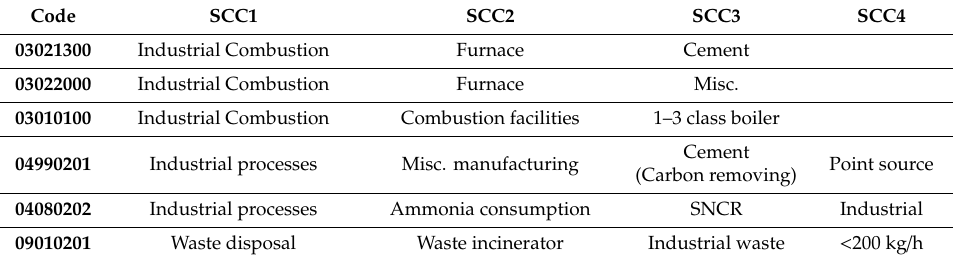
Table 2. CAPSS Source Classification Codes corresponding to emissions by the cement industry.